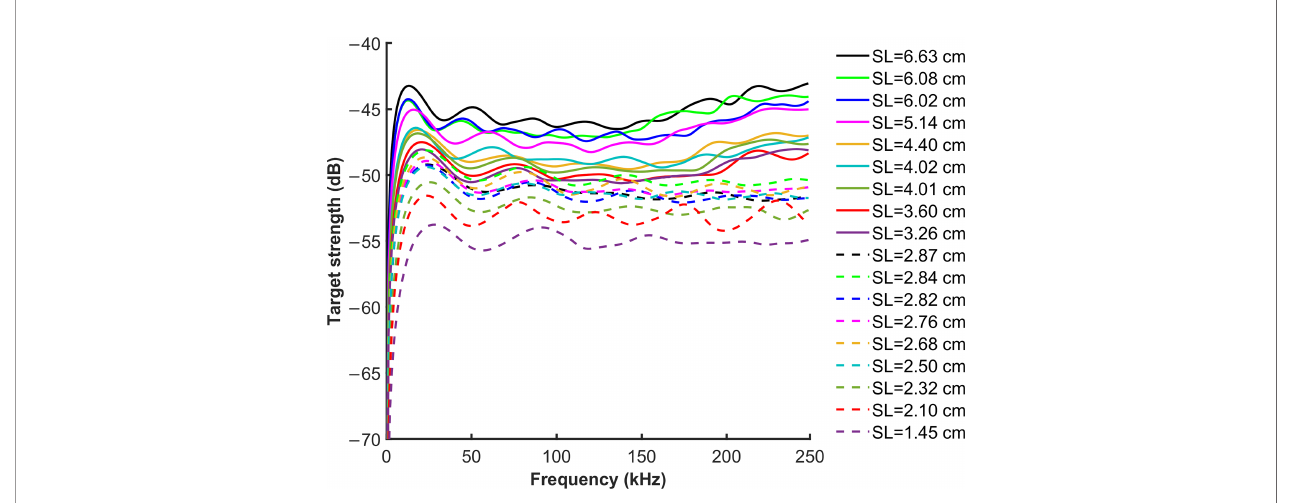
FIGURE 6 | The broadband TS spectrum of the 18 S. japonicus , was estimated using the pitch angle distribution N[ − 3°,4°], in the frequency range of 0 – 250 kHz. The low frequency resonance range is shown, the wide peak is the swim bladder resonance. The solid line refers to the individuals with SL >3 cm ; the broken line refers to individuals with SL<3 cm